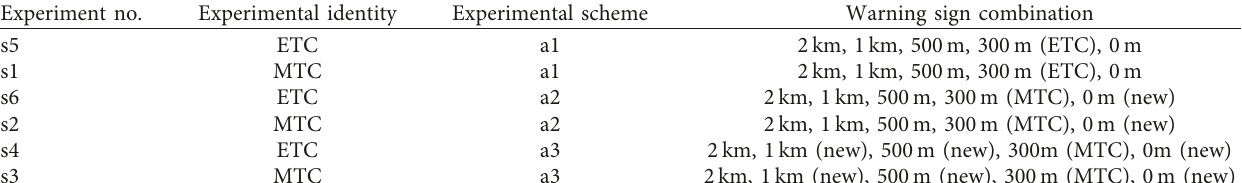
Table 2: Experimental design grouping.